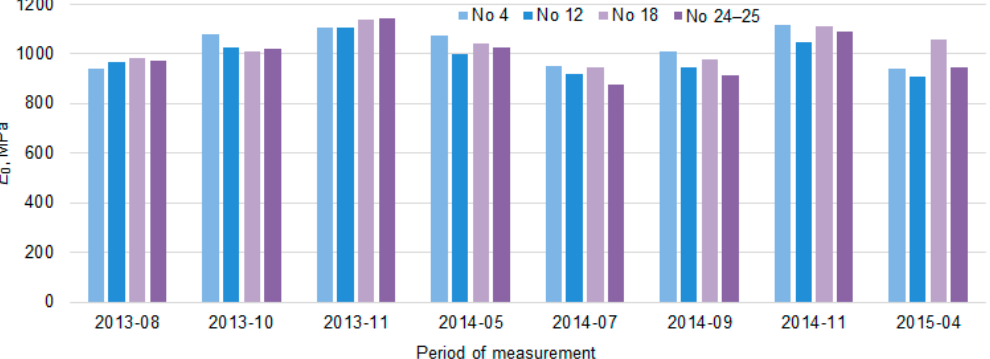
Figure 21. The average values of bearing capacity in different periods of the unloaded lane of PS No 4, No 12, No 18 and No 24–25.